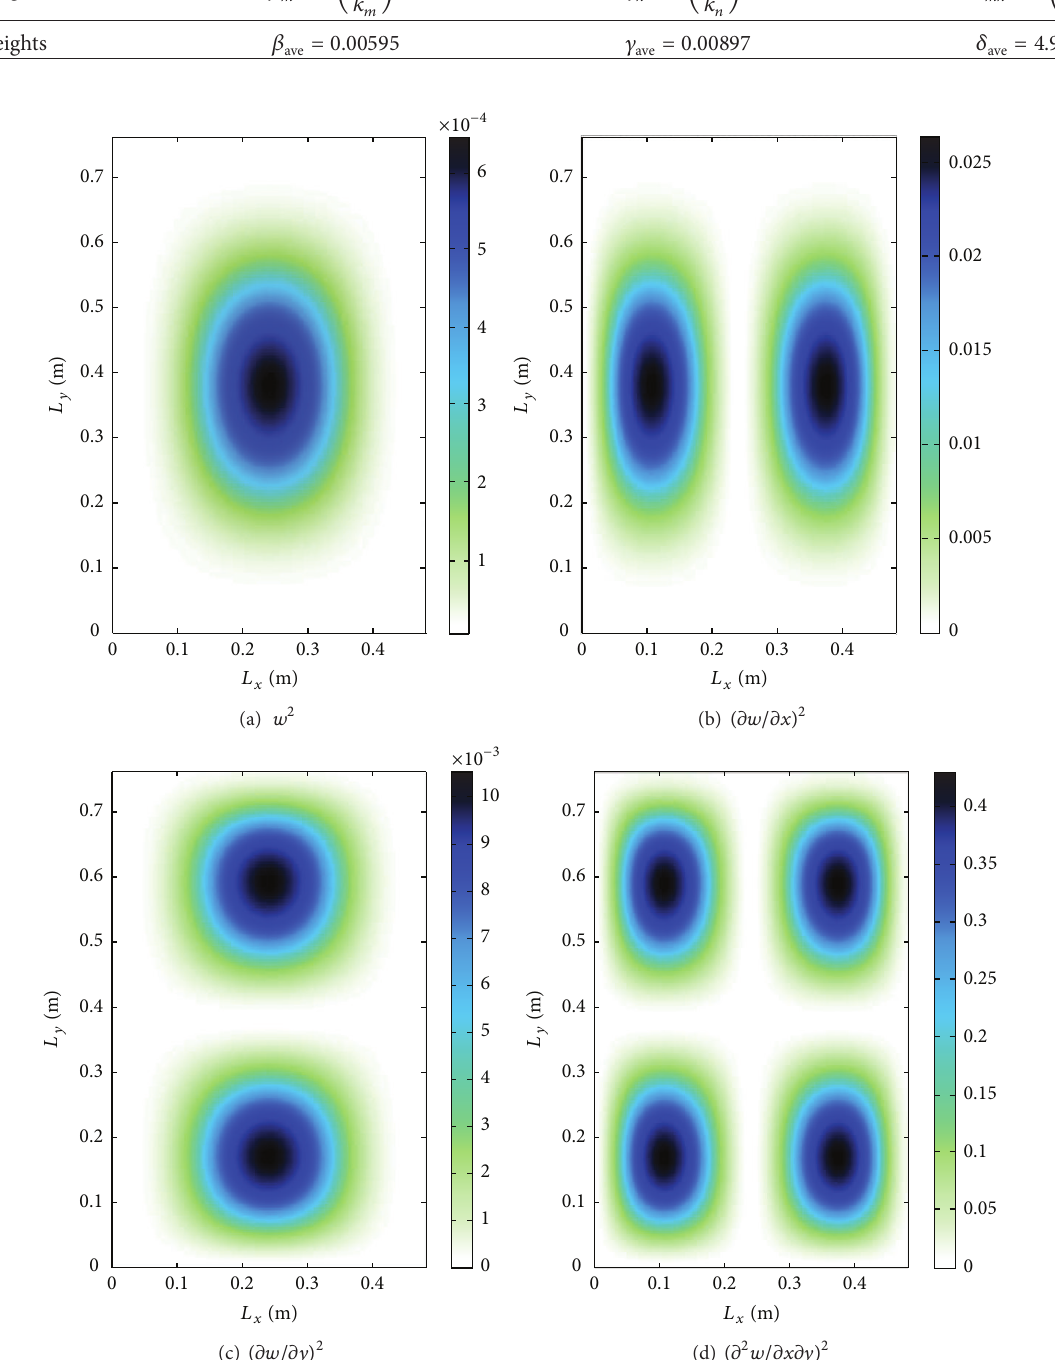
Figure 2: Analytical WSSG terms for the first structural